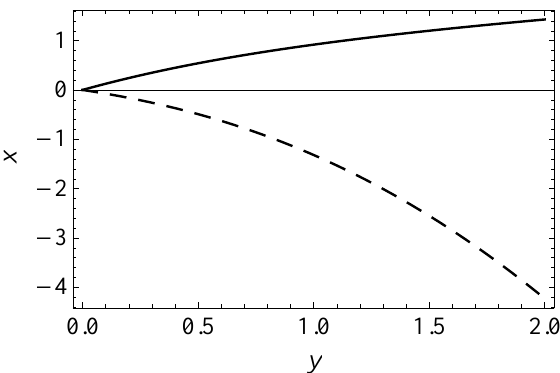
Fig. 1. Normalized dispersion relation branches. Solid and dashed curves correspond to the two solutions of Eq. (3) for U = 0 . 3.